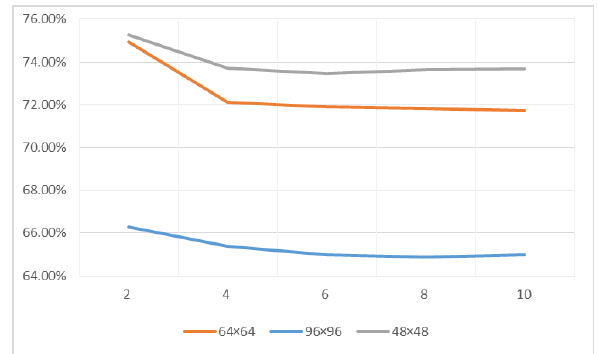
Figure 5. Class average accuracy while changing K ． The horizontal axis represents the parameter K and the vertical axis represents the class average accuracy.